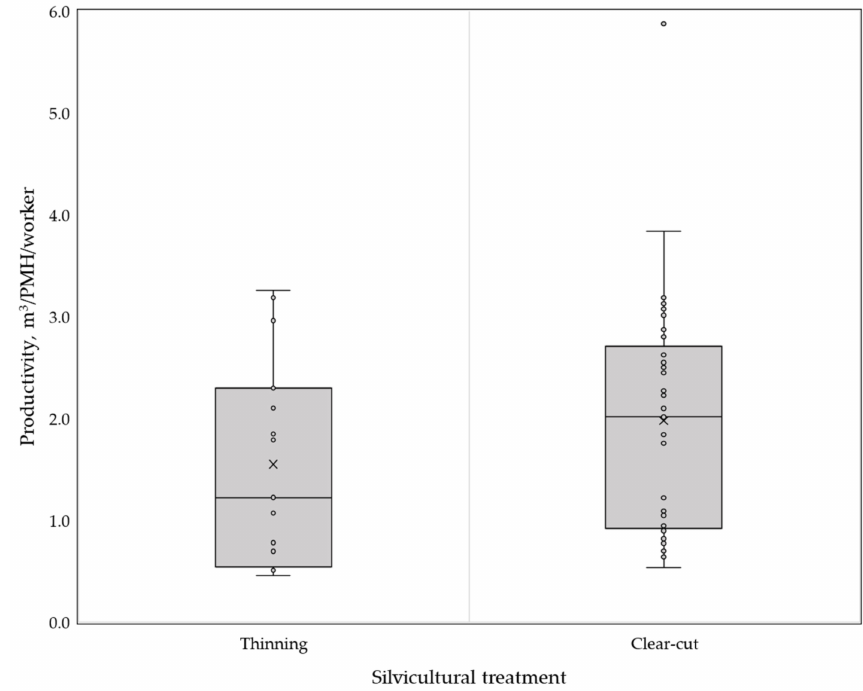
Figure 2. Changes in productivity evaluated for thinning and clear-cut treatments at mean yarding distances of 64 and 72 m, respectively. The circles are data points, and the × is the mean